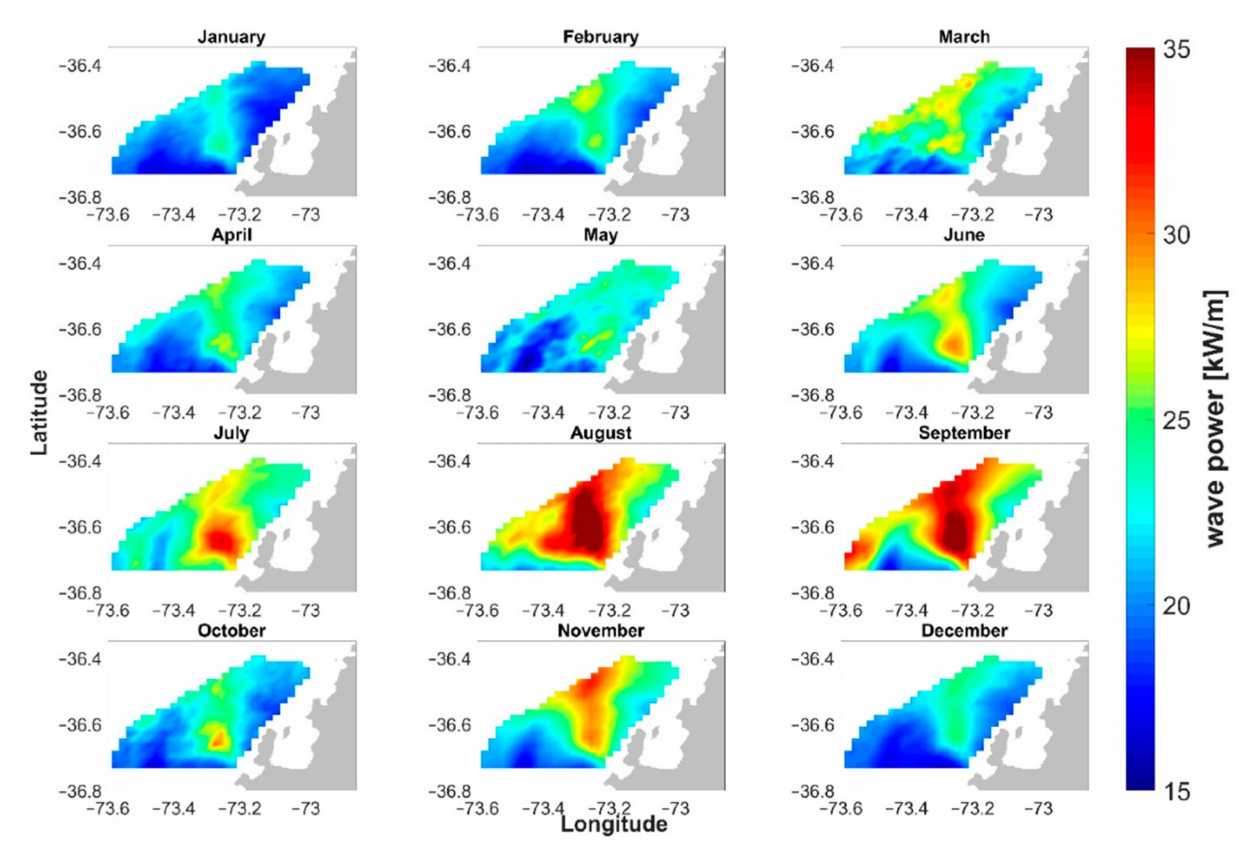
Figure 8. Wave potential monthly mean fields estimated on the basis of data provided by a phased array HF radar system installed off the coast of Chile